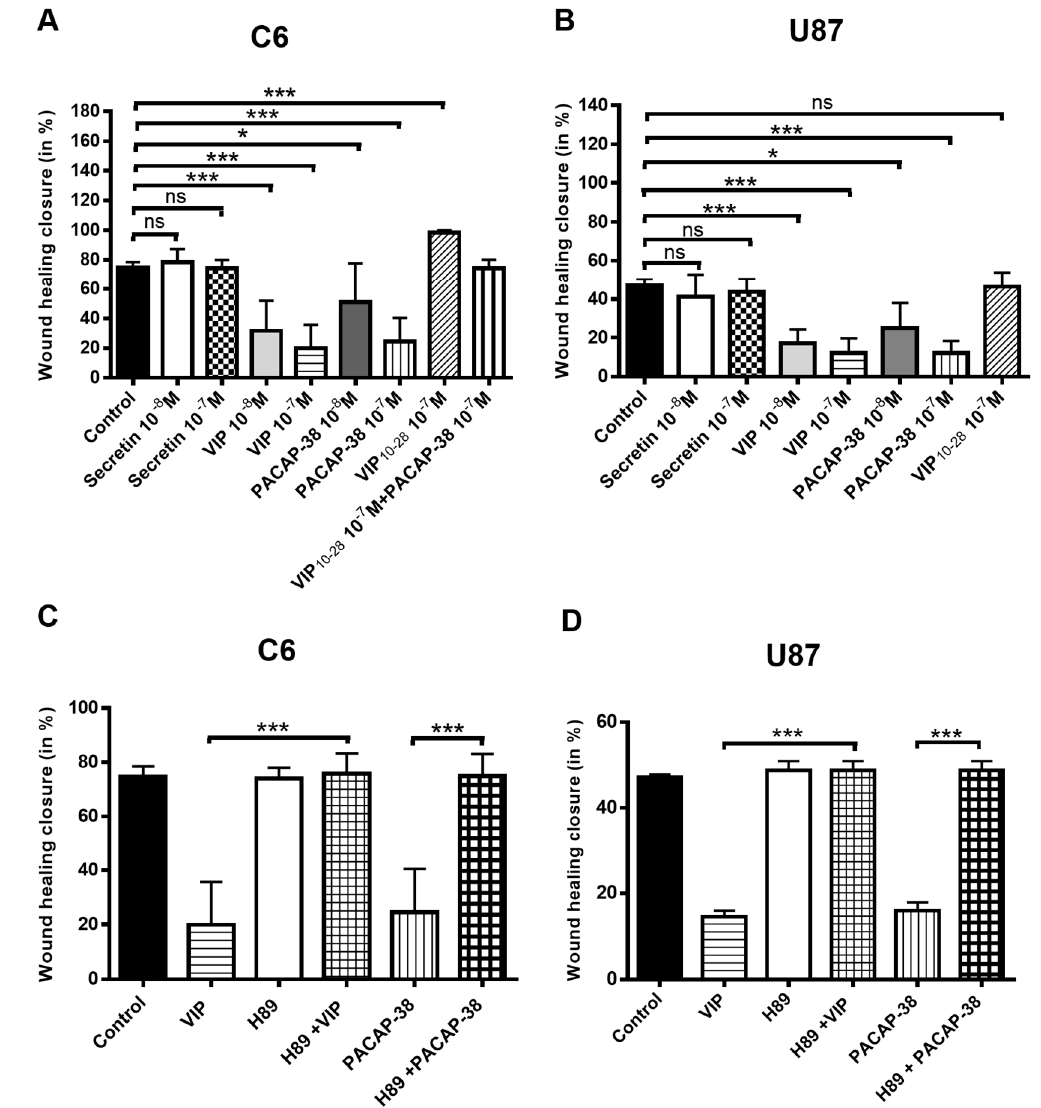
Figure 2. Effects of VIP, PACAP-38, VIP 10-28 and/or inhibitors of signaling pathways H89 (PKA inhibitor), IA (Akt inhibitor), on the migration process of C6 and U87 cells. Migration was analyzed by the technique of wound healing closure, as described in Materials and Methods. ( A , B ) Effect of neuropeptides on the migration of C6 or U87 cells. ( C , D ) Migration of C6 and U87 cells treated or not with VIP or PACAP-38 at 10 − 7 M in absence or presence of H89. Data represent the wound healing closure expressed in % and are the mean ± SD of at least three independent experiments, each performed in duplicate. Data were analyzed using the Kruskal–Wallis test and Dunn’s post hoc test (* p < 0.05, *** p < 0.001, ns: not significant).